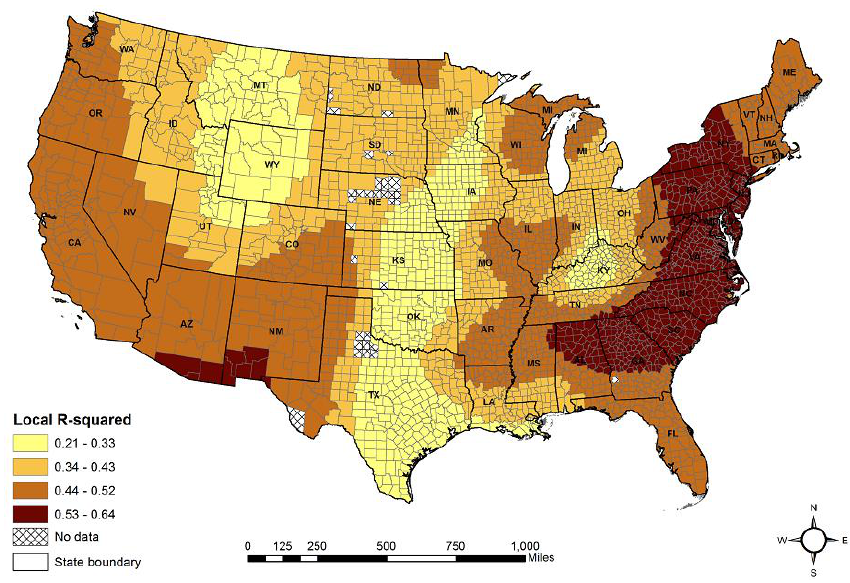
Figure 4. Local R 2 values from the GWR model.